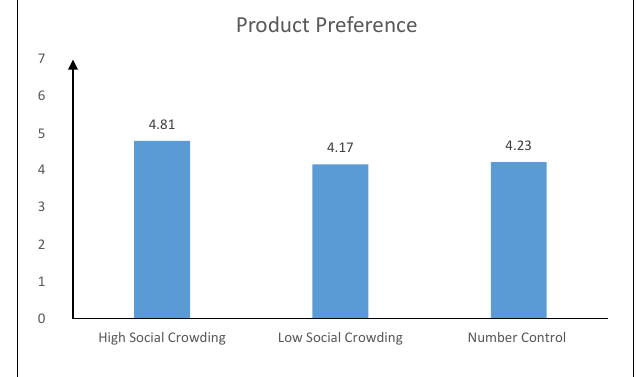
FIGURE 2 | The results of product